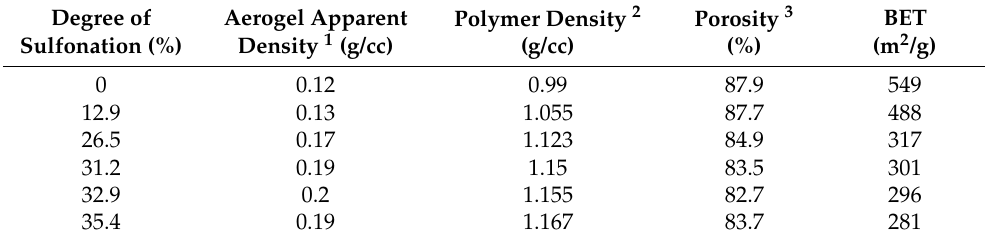
Table 1. Aerogel apparent density and porosity, BET values of PPO aerogels with different degrees of sulfonation. Degree of Sulfonation (%)